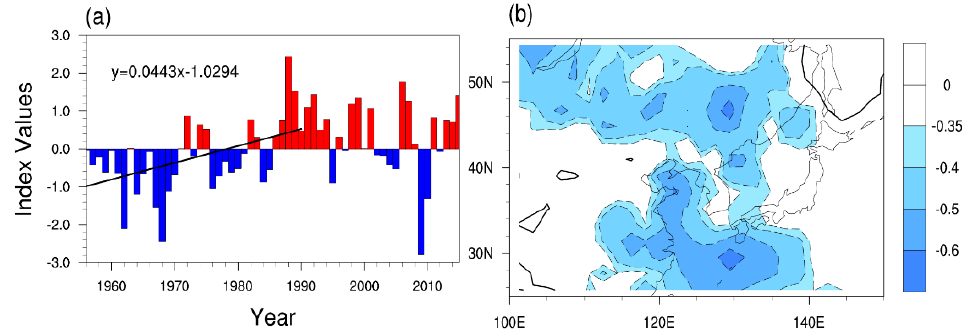
Figure 7. ( a ) Time series of AO index (bar) during 1956–2015. Black line refers to linear trend of AO during 1956–1990; ( b ) map of correlation coefficients between AO index and the number of cold days at each grid point in winter over East Asia during 1956–1990. Shaded values are significant, exceeding 95% confidence level based on Student’s t -test.